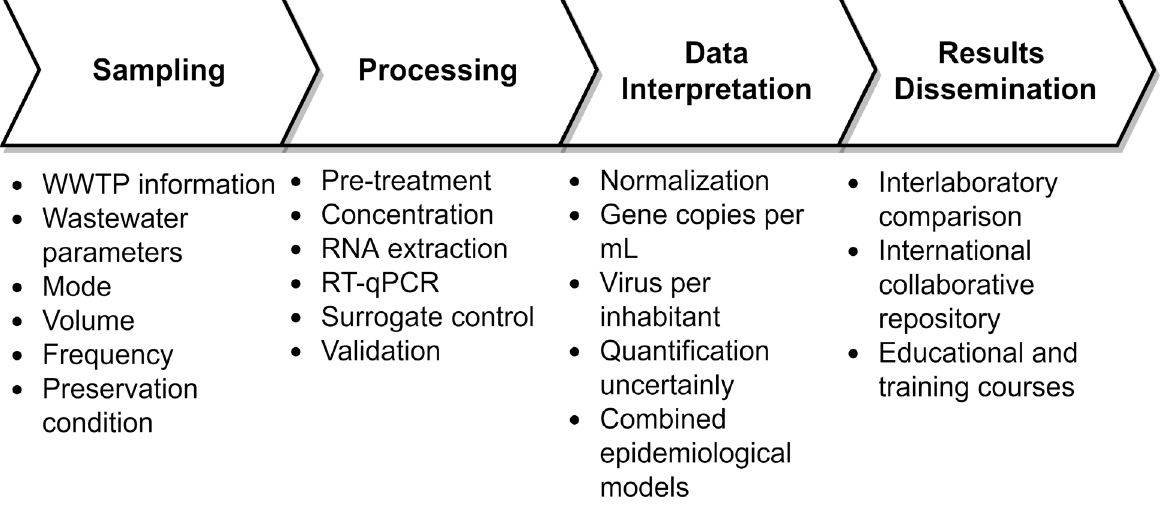
Figure 3. Main steps of a SARS-CoV-2 epidemiological surveillance strategy in